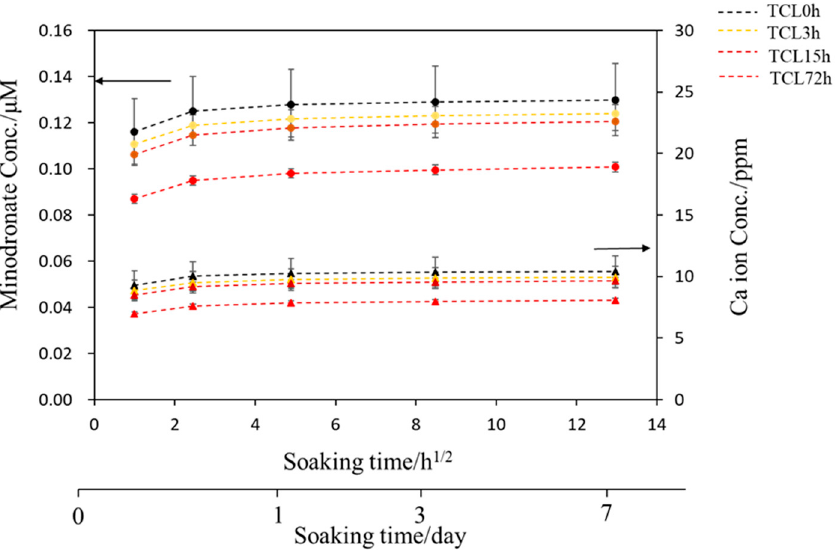
Figure 7. Calcium ion release into PBS from the sample CT10G + MA + Ca without or with thermal cross-link treatment for periods of 3–72 h. The released minodonate was estimated from the Ca ion concentration in PBS for each soaking period.